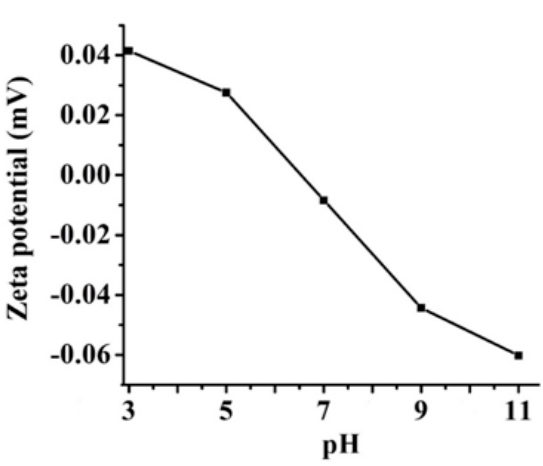
Figure 8. Effect of pH on Zeta potential of the bio-PAC. Figure 8. E ff ect of pH on Zeta potential of the bio-PAC.